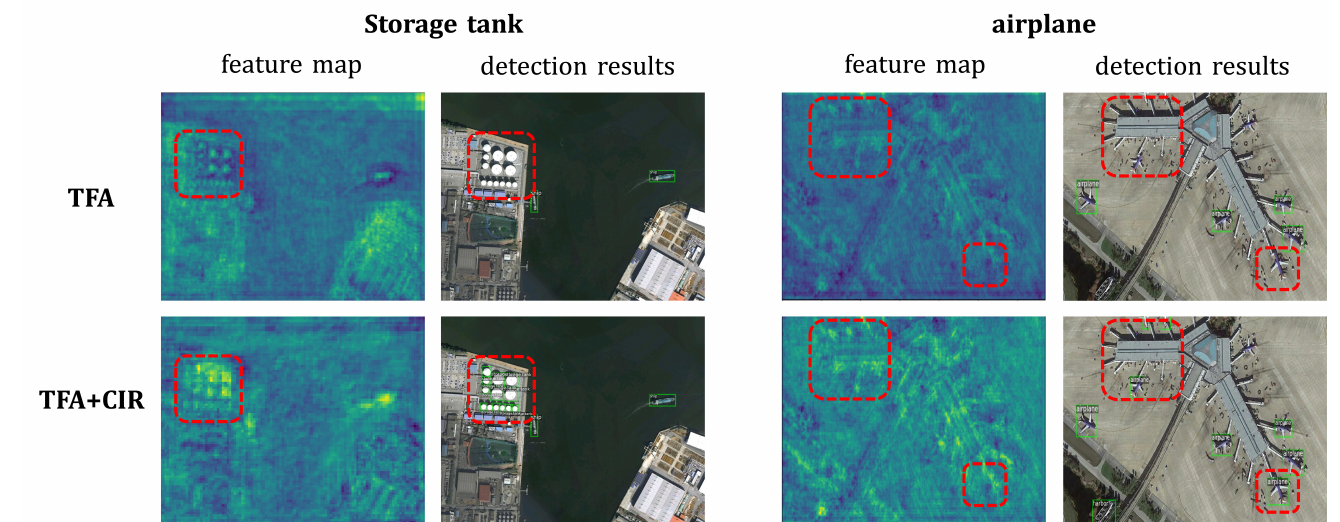
Figure 11. Feature map and the detection results of the proposed network under two examples. Top : feature map and detection results without CIR. Bottom : feature map and detection results with CIR. The green boxes are made by the detector and the red boxes are the areas we focus